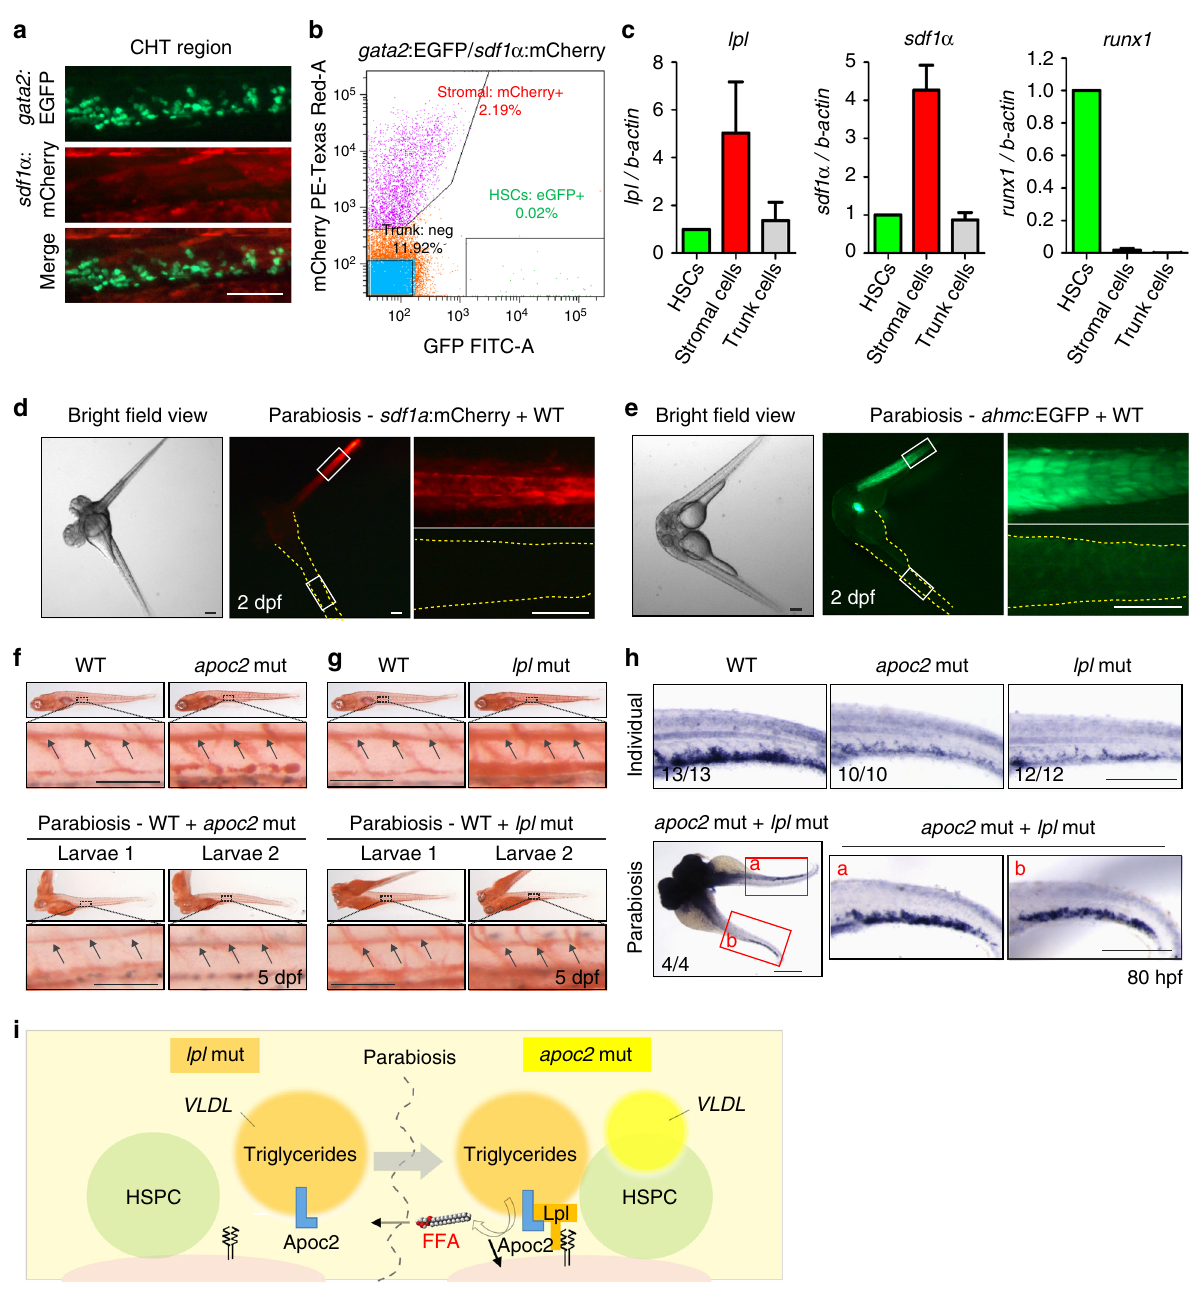
Fig. 5 Parabiosis of apoc2 and lpl mutants rescues defective hematopoiesis. a The CHT region of gata2: EGFP, sdf1a :mCherry double-positive embryos at 2.5 dpf. b Flow cytometry of gata2: EGFP and sdf1a :mCherry positive cells isolated from the CHT region. c RT-qPCR analysis of FACS-sorted gata2: EGFP and sdf1a :mCherry positive cells, using lpl , runx1 and sdf1 α primers. Mean± SD of two independent experiments. d , e Parabiosis of a sdf1 α :mCherry or a ahmc : EGFP with a WT embryo. Right-hand panels are enlarged segments showed in white quadrangles in left-hand panels. Yellow dashed lines trace WT embryos ’ boundaries. f , g Rescue of hyperlipidemia in apoc2 or lpl mutants by parabiosis with WT embryos. Upper panels: two separated embryos (WT and apoc2 or lpl ). Lower panels: larva 1 and larva 2 from a parabiosis pair (WT with apoc2 or WT with lpl ). Black arrows point to ORO staining in the lumen of blood vessels. h In situ hybridization with runx1/cmyb probe in WT, individual apoc2 and lpl mutants, and parabiotic apoc2 and lpl mutants at 80 hpf. Scale bars, 50 μ m in f , g , and 200 μ m in a , d , e and h . i Diagram of lipoprotein metabolism in parabiotic lpl and apoc2 mutants. In the lpl mutant, no Lpl is expressed. However, VLDL secreted by the lpl mutant (orange) delivers Apoc2 through the shared circulation to the apoc2 mutant, in which Lpl is expressed but its own VLDL (yellow) contains no Apoc2. VLDL from the lpl mutant compensates lack of Apoc2 in the apoc2 mutant and the reconstituted Apoc2/Lpl catalyzes hydrolysis of TG to release FFAs into the shared circulation, which in turn rescue the hematopoiesis defect in both fi nd a reduction in the total levels of FFAs in total body homo- that can be made de novo, trended higher or were not changed in genates of apoc2 mutants compared to WT (Supplementary apoc2 mutants. However, levels of DHA (22:6n3), which in zeb- Fig. 8, bottom-right graph). This can be explained by a com- ra fi sh can only be derived from TG hydrolysis, were signi fi cantly pensatory FFA synthesis in apoc2 mutants. Indeed, levels of FFAs lower in 26 hpf embryos (Fig. 6 and Supplementary Fig. 8).